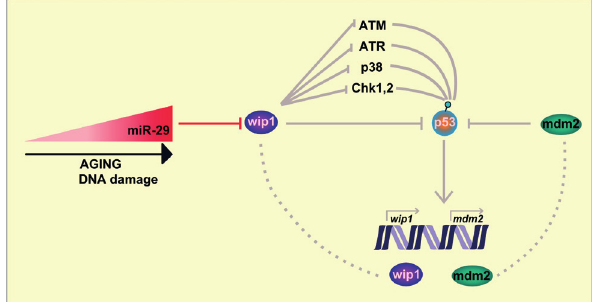
Fig. 3. Inhibition of p53 pathway by miR-29. Upregulation of miR-29 with increasing age and DNA damage inhibits Wip1 phosphatase. After that, Wip1 phosphatase cannot repress DNA damage responsefactors and p53. Wip1 and mdm2 are not transcribed by p53 which is not phosphorylated. Cell cycle is